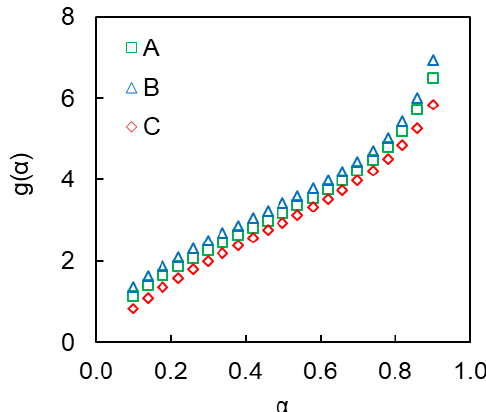
Figure 12. Experimental g ( α ) data for polymerization of cyanate ester confined to SCCs (A–C).